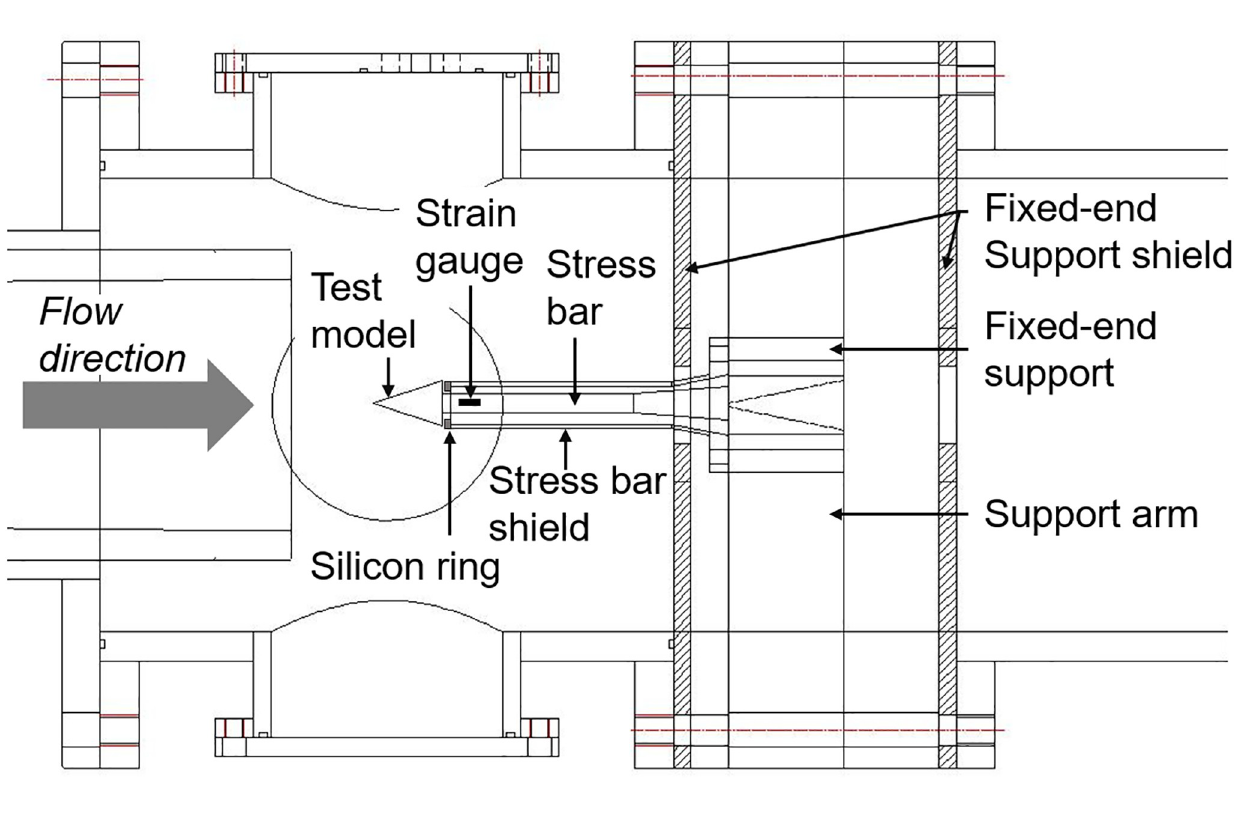
Fig 5. Schematic of the SWT